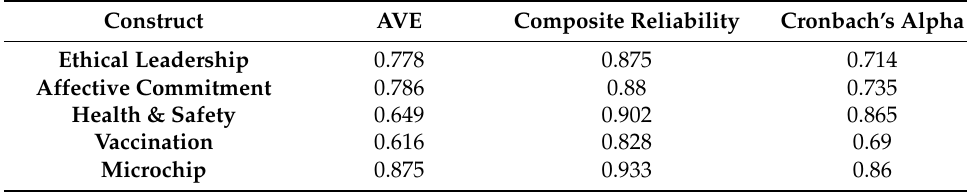
Table 2. Reliability